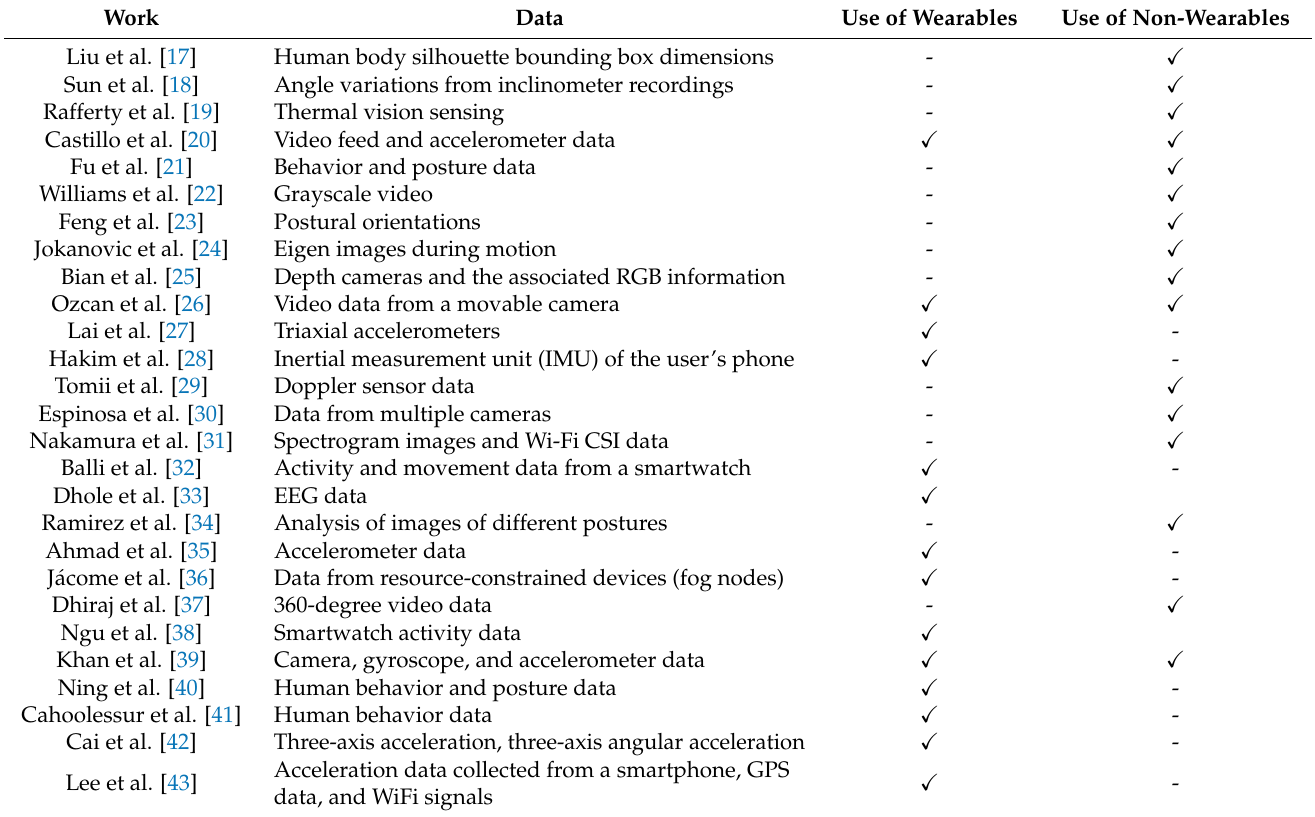
Table 1. Summary of recent works in fall detection along with their source of